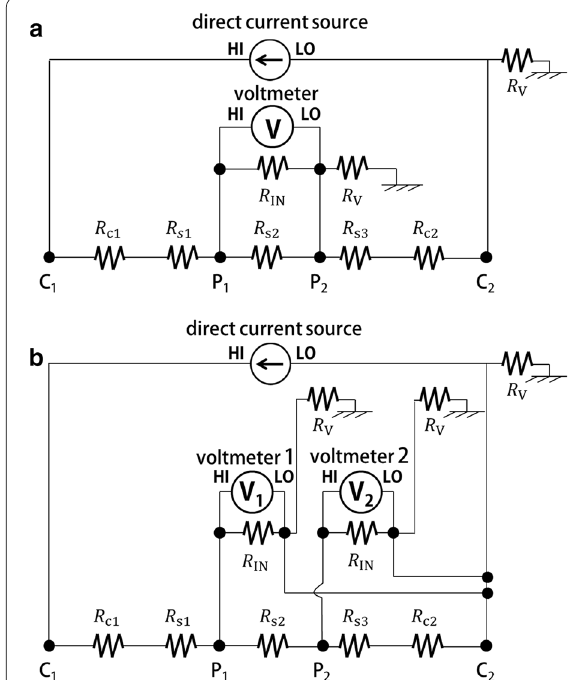
Fig. 1 Circuitry of a the conventional four-terminal method and b the differential measurement method adopted here. R IN is input resistance, R V is the insulation resistance between the negative terminal and chassis ground, R c is the contact resistance between the electrode and sample surface, and R s is the sample resistance. HI labels positive terminals, LO labels negative terminals, C 1 and C 2 are current electrodes, P 1 and P 2 are potential electrodes. In a when the sum of R s3 and R c2 is much smaller than R IN or R V , no current flows into the voltmeter. However, in a voltmeter, R V is usually much smaller than R IN . When R V is less than the sum of R s3 and R c2 , current flows into R V through the negative terminal of the voltmeter, preventing correct voltage measurement. In b , R V does not contribute to the current path, and when R IN is larger than the sum of R s3 and R c2 , most of the current does not flow to the voltmeter. The differential method uses two voltmeters, whose positive terminals are connected to P 1 and P 2 , and whose negative terminals are shorted to the negative terminal of the current source. The voltage between P 1 and P 2 is obtained as the voltage difference between the measured values of V 1 and V 2 . In addition to this circuitry, the guarding to reduce current leakage is adopted as described in the main text; however, the shield is not drawn in this figure to avoid complexity of the diagram.